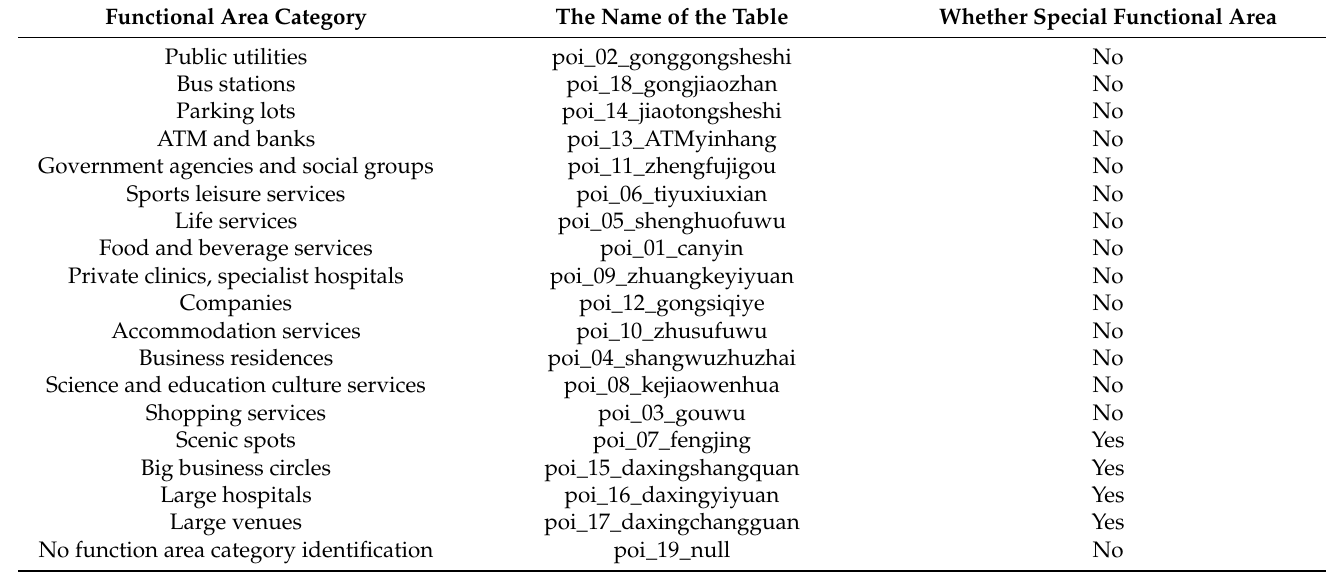
Table 1. Urban functional areas